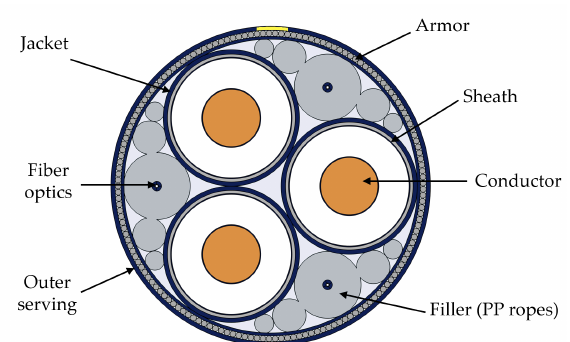
Figure 1. Elements in a